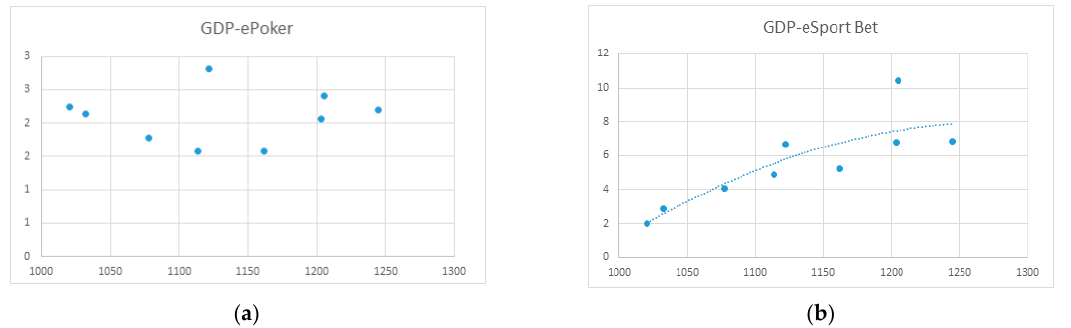
Figure 8. ( a ) Regression function between GDP and online poker; ( b ) Regression function between GDP and online sports betting. No relationship was identified between GDP and e-Poker spending. Regression analyses between GDP and online sports betting spending established a polynomial regression: y = −9 × 10 −5 x 2 + 0.2262x − 136.81 ( R ² = 0.73; F = 19.71; p < 0.001)